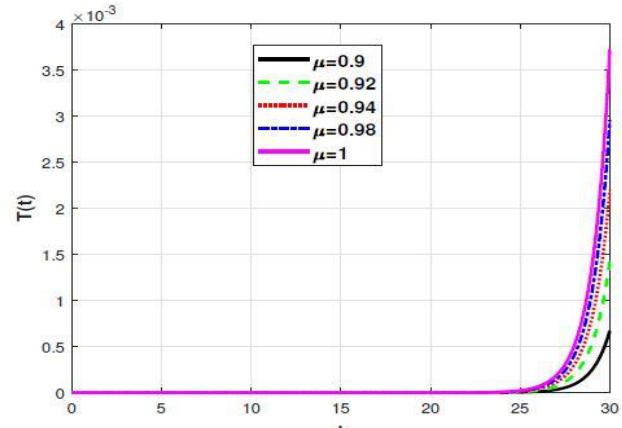
Fig. 6. Numerical experiments of recognized symptomatic infected class for various value of fractional order 𝛍